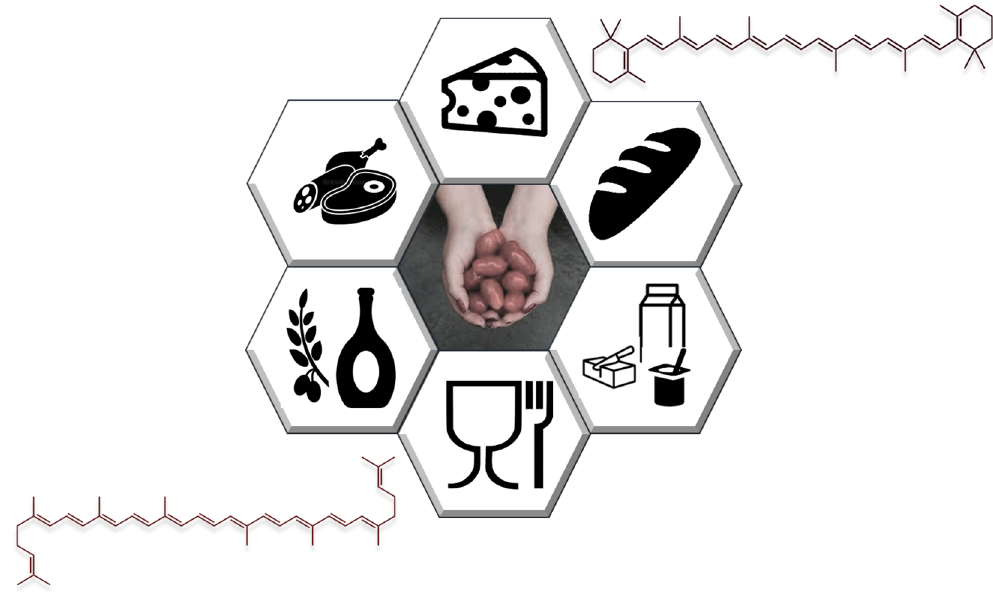
Figure 5. Applications of carotenoids derived from tomato in the food industry